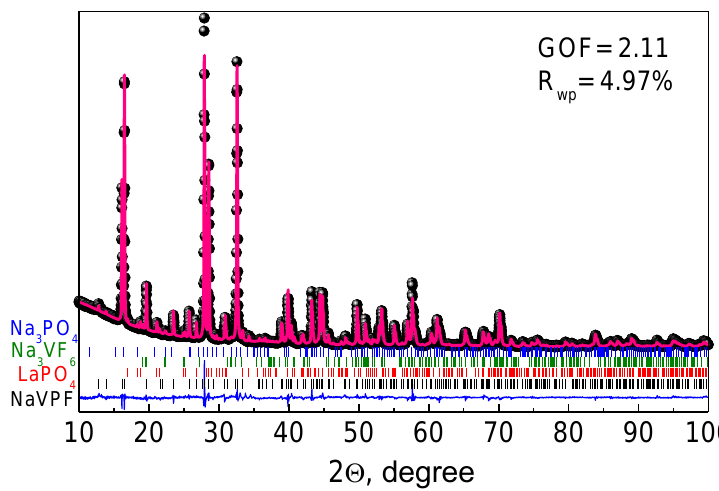
Figure 2. Rietveld refined XRD pattern of the NVPF-La05 sample. Table 1. Phase composition of the as-prepared samples and the Rietveld refined XRD lattice parameters of the Na 3 V 2 (PO 4 ) 2 F 3 main phase.